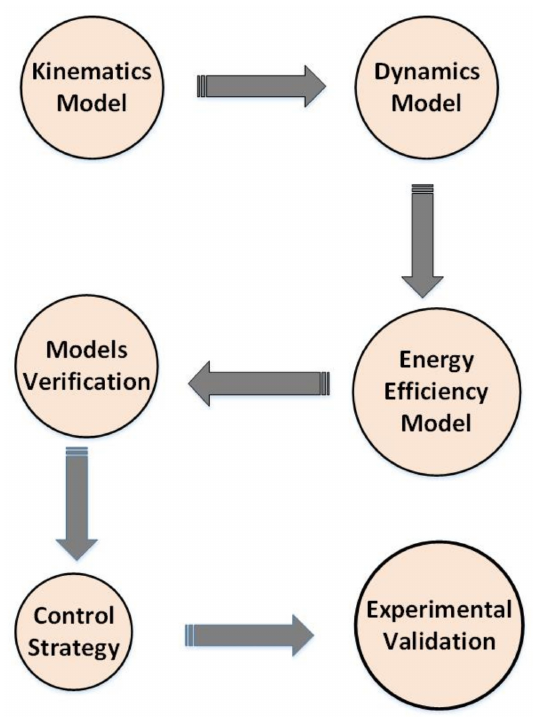
Figure 1. Block diagram representation of the proposed